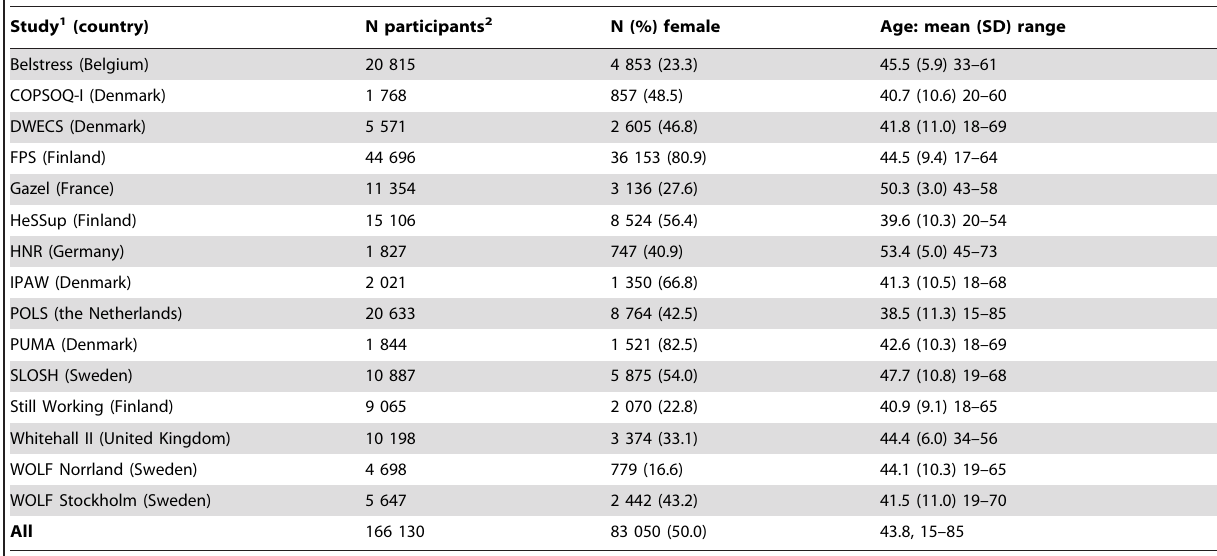
Table 1. Summary of studies and